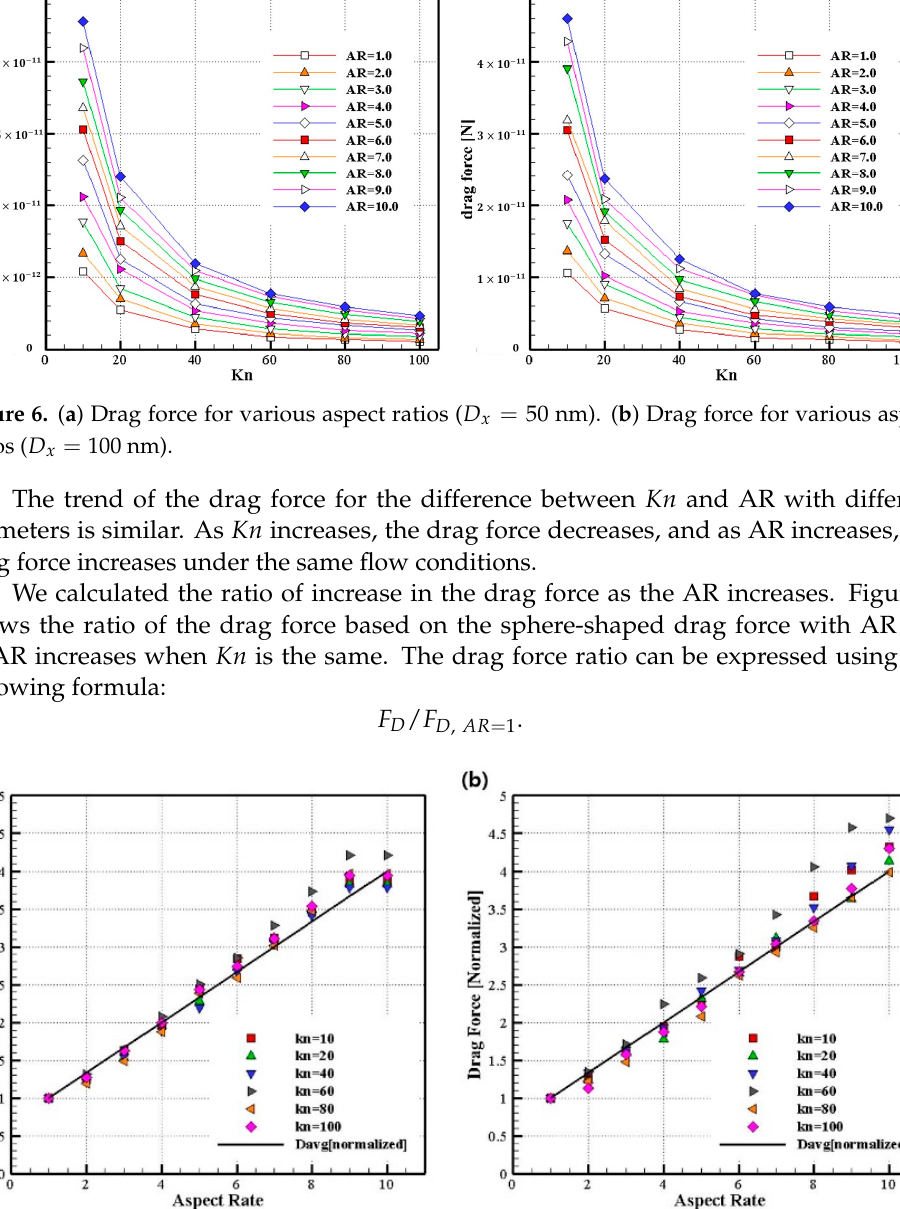
Figure 5. ( a ) The shape of the ellipsoid with aspect ratio. ( b ) Force per area on ellipsoidal particle surface for various angles.